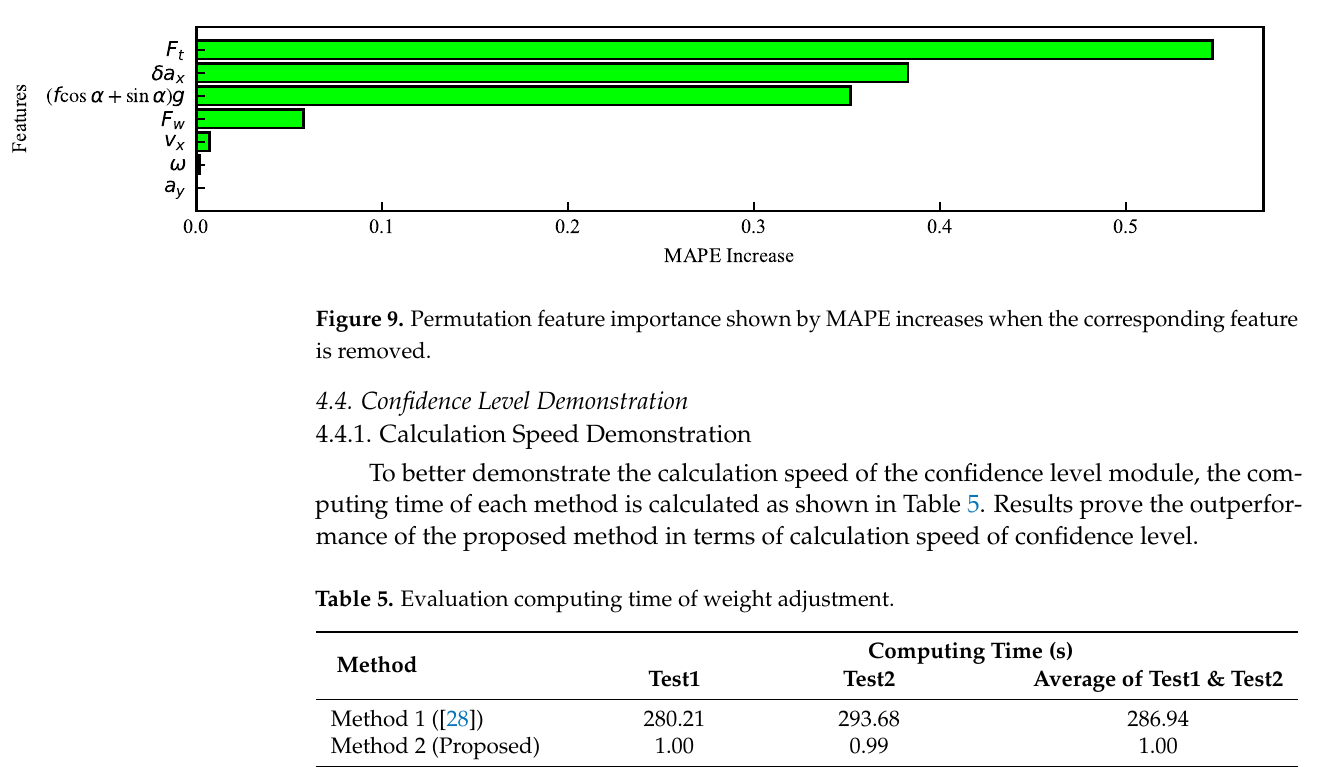
Table 6. Evaluation metrics of different weight factors.